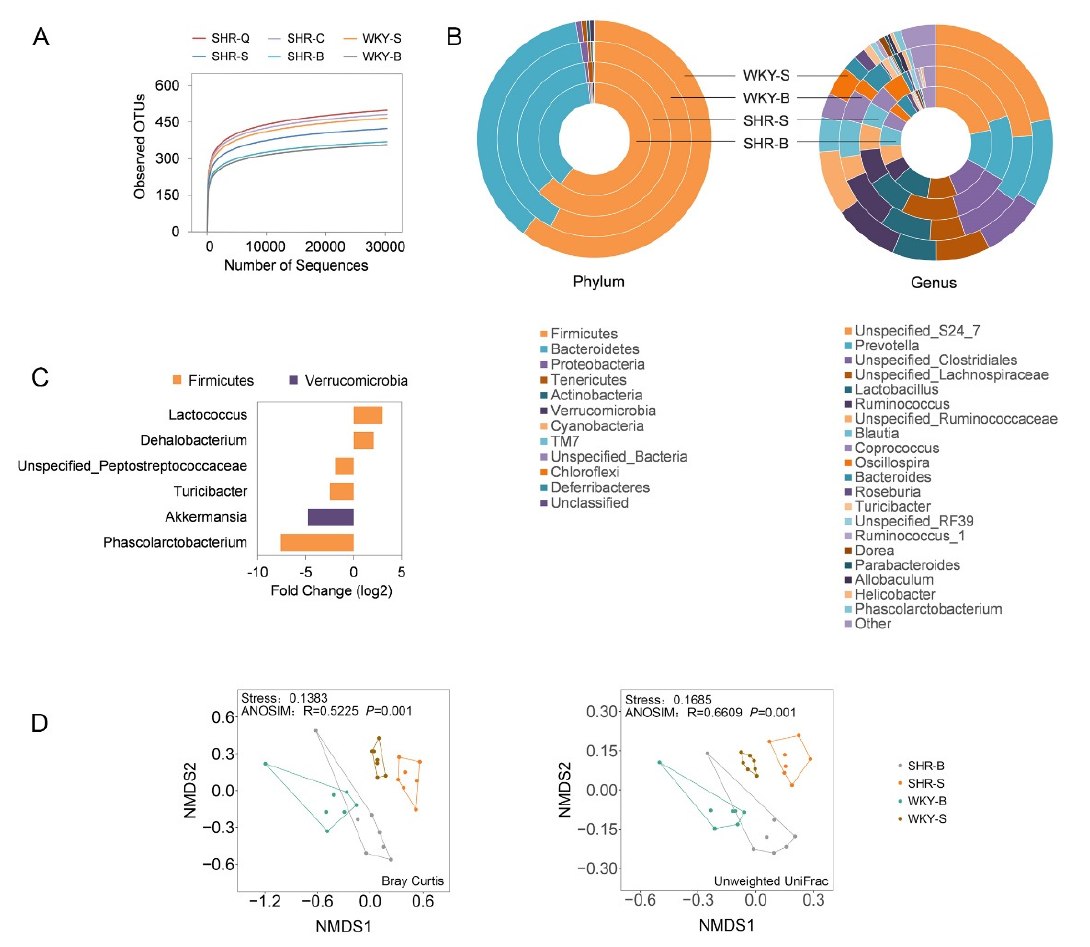
Figure 2. Significant differences in fecal microbial compositions between spontaneously hypertensive rats (SHRs) and Wistar Kyoto rats (WKYs). SHR–B and WKY–B: rats at baseline (10-week-old); SHR–S and WKY–S: rats administrated by saline solution for five weeks (15-week-old); SHR–Q and SHR–C: rats orally administrated by quinoa protein and captopril for five weeks (15-week-old), respectively. ( A ) Rarefaction curves. ( B ) Relative abundance of fecal microbiotas at the phylum and genus levels in rats. Four layers of donuts from the center to the outside represent the relative abundance of fecal microbiotas in SHR–B, SHR–S, WKY–B, and WKY–S, respectively. ( C ) Differentially abundant genera by DESeq2 (P adj < 0.01) when SHR–S vs WKY–S. ( D ) β -diversity of the fecal microbiota based on nonmetric multidimensional scaling (NMDS) analysis.